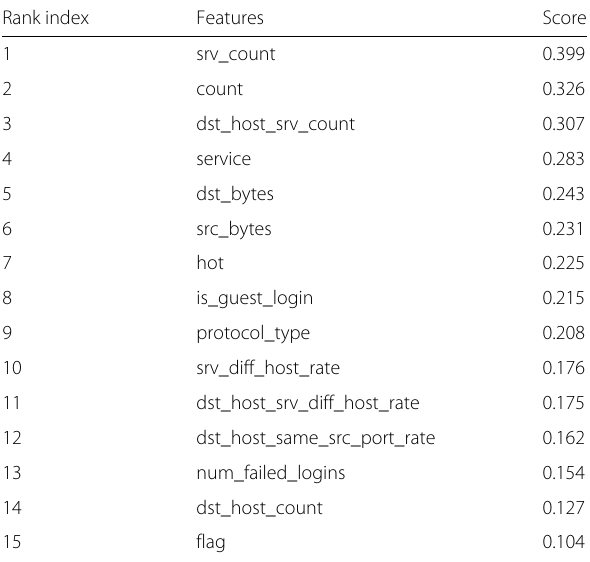
Table 6 Top features for detecting R2L, used in the